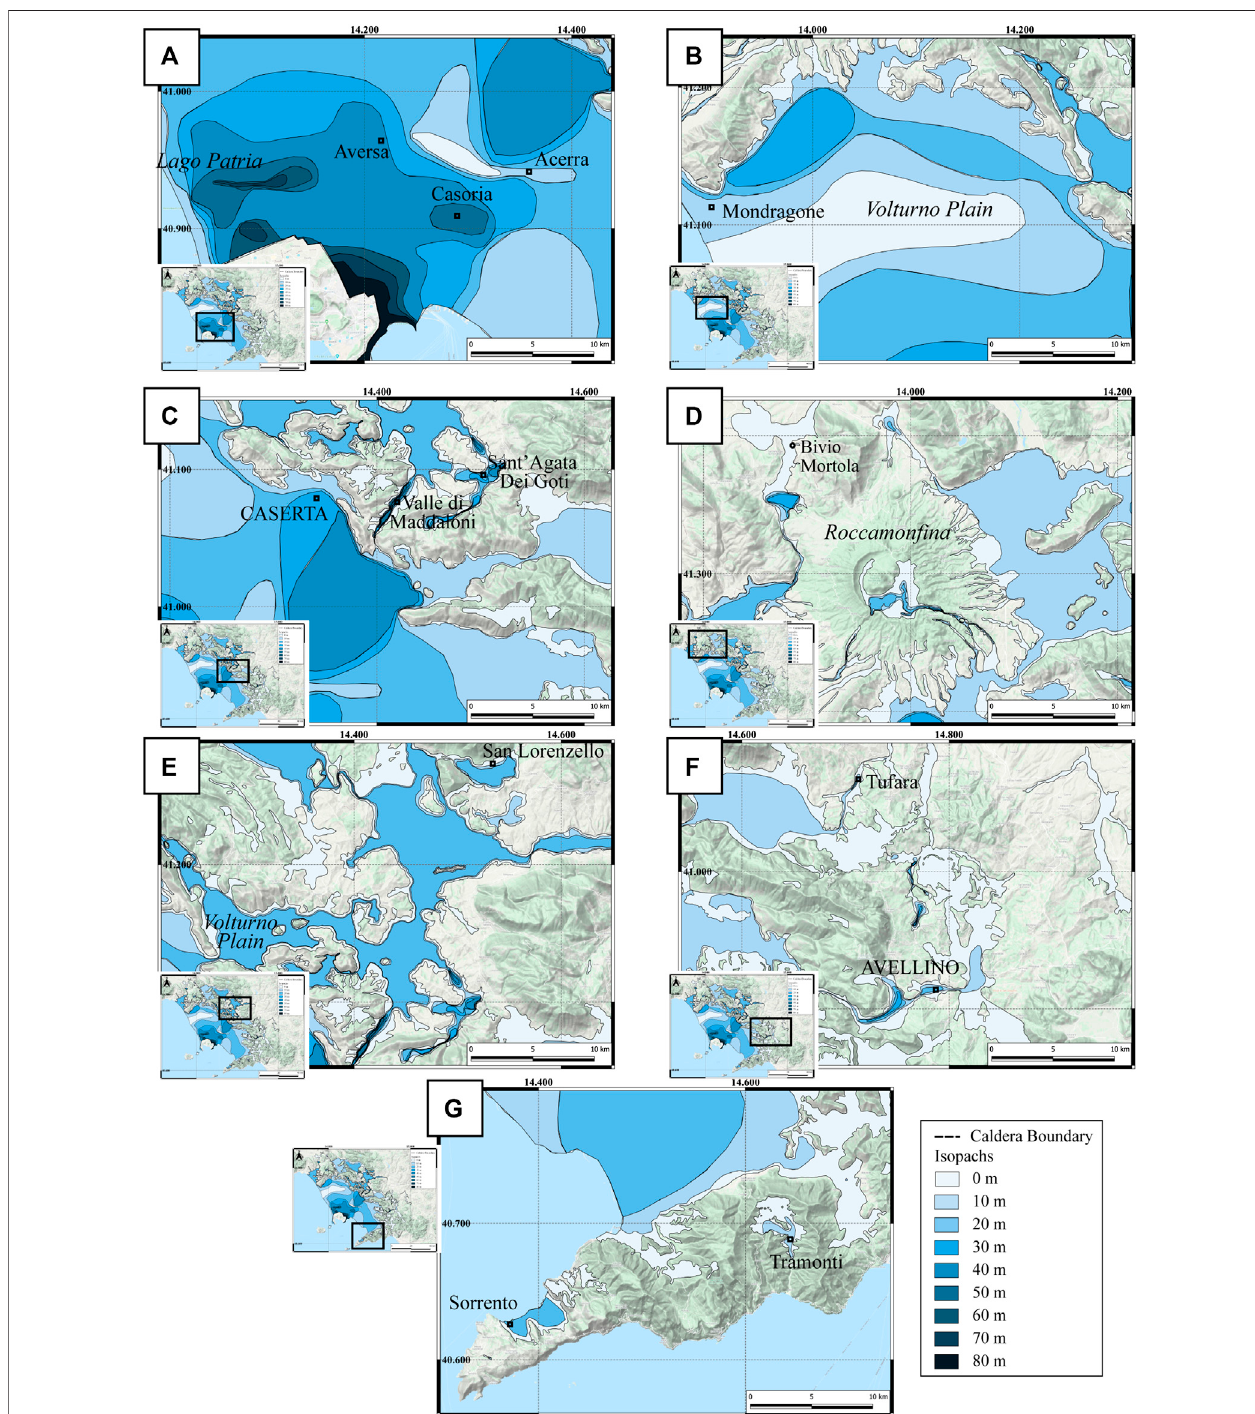
FIGURE 6 | Detailed isopach maps of selected areas of the Campanian Ignimbrite (excludes fallout): (A) north of the caldera, between Lago Patria and Acerra; (B) northern part of the Campanian Plain; (C) Apennine ridges east of the Campi Flegrei caldera and the Valley of Maddaloni; (D) Roccamon fi na and Mortola, in the north of the studied area; (E) Volturno plain and San Lorenzello area, northeast of the caldera; (F) distal area of Avellino, southeast of the caldera; (G) Sorrento peninsula, in the southern part of the studied area. See The Isopachs to detailed methods on how the isopachs were traced.